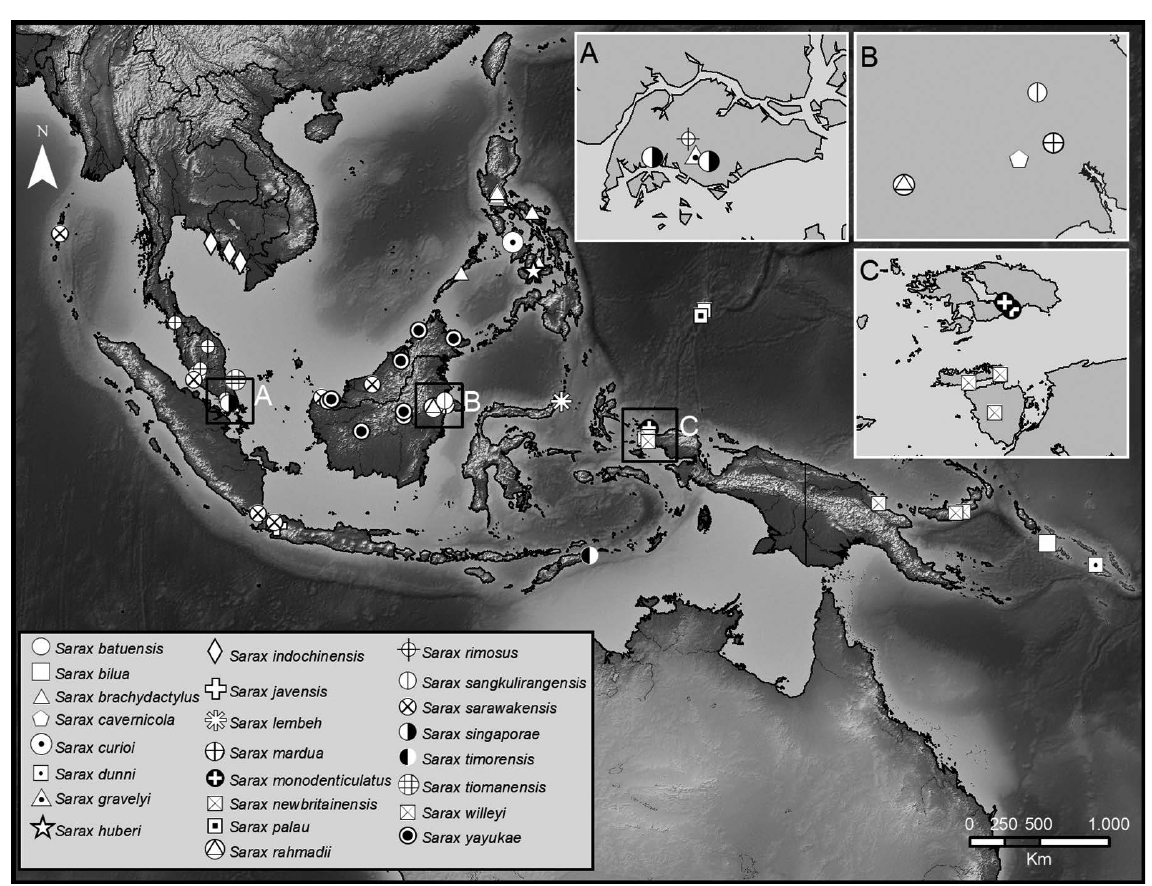
Fig. 103. Map plotting known distributions of species of Sarax Simon, 1892 in Southeast Asia and Oceania, with insets for Singapore (A), eastern Borneo (B), and western West Papua